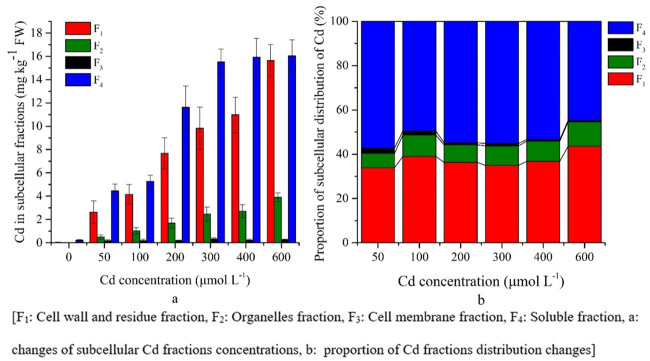
Subcellular distribution of Cd in S. portulacastrum stems.